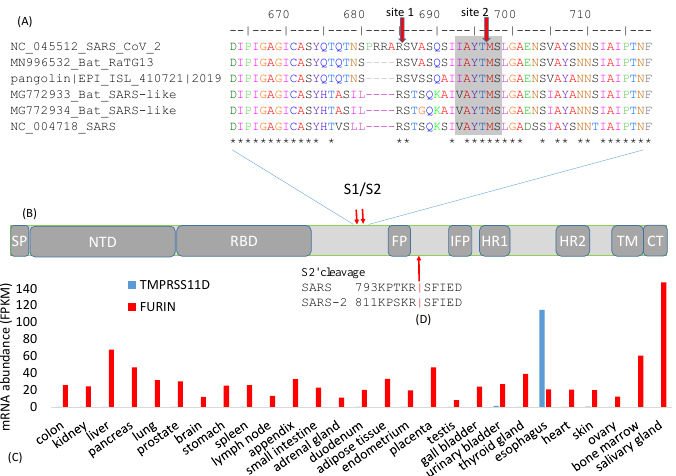
Figure 2. Cleavage sites at the S1/S2 boundary. ( A ) An insertion of 12 nt in SARS-CoV-2 results in a new polybasic furin cleavage site, resulting in two cleavage sites indicated by the red downward arrows. Numbers follow ( B ) Schematic domain structure of S protein, with the same abbreviation as in Figure 1A; ( C ) Tissue-specific mRNA distribution of human trypsin-like protease TMPRESS11D and FURIN, derived from [30]; ( D ) Cleavage site for splitting S2 into FP and S2′ domains. The cleavage of the S protein into S1 and S2 is an essential step in viral entry into a host cell, and needs to occur before viral fusion with the host cell membrane [6]. Different cleavage sites targeted by different proteases are often associated with drastically differ- ent virulence and host cell tropism in various RNA viruses. For example, the low-patho- genicity forms of the H1N1 influenza virus has a cleavage site by trypsin-like proteases [31] in contrast to the high-pathogenicity forms with a furin cleavage site cleaved by furin- like proteases [32]. Trypsin-like proteases typically have a narrow tissue distribution in humans. For example, trypsin-like transmembrane serine protease 11D (gene name TMPRSS11D) is expressed only in the esophagus (Figure 2C). Another member of the trypsin family, PRSS1, is expressed mainly in the pancreas [30]. In contrast, furin-like pro- teases are ubiquitous (Figure 2C). Thus, if a coronavirus needs to be cleaved TMPRSS11D or PRSS1, then its cellular entry is limited to the esophagus where TMPRSS11D is ex- pressed (Figure 2C) or the pancreas where PRSS1 is expressed. However, if the virus gains a furin cleavage site, then this restriction is removed because FURIN is ubiquitous in hu- man tissues (Figure 2C), resulting in dramatic broadening of host cell tropism. In this con- text, the S protein contributes to host specificity [6], and also to tissue specificity through its differential requirement of tissue-specific proteases. For this reason, viruses with dif- ferent cell tropism may accumulate tissue-specific genomic signatures [33]. Because the C-terminus of the spike protein is anchored inside the viral membrane, one might expect the distal S1 to be lost after cleavage at site 1. However, the distal S1 subunit remains non-covalently bound to the S2 unit in the prefusion conformation after cleavage at site 1 [10,11,34]. In order to stabilize the prefusion conformation to facilitate vaccine design [10,35] or structural determination [11,12], the furin site is often mutated so that it is not cleaved. For example, the cleavage site RRAR was changed to GSAS in